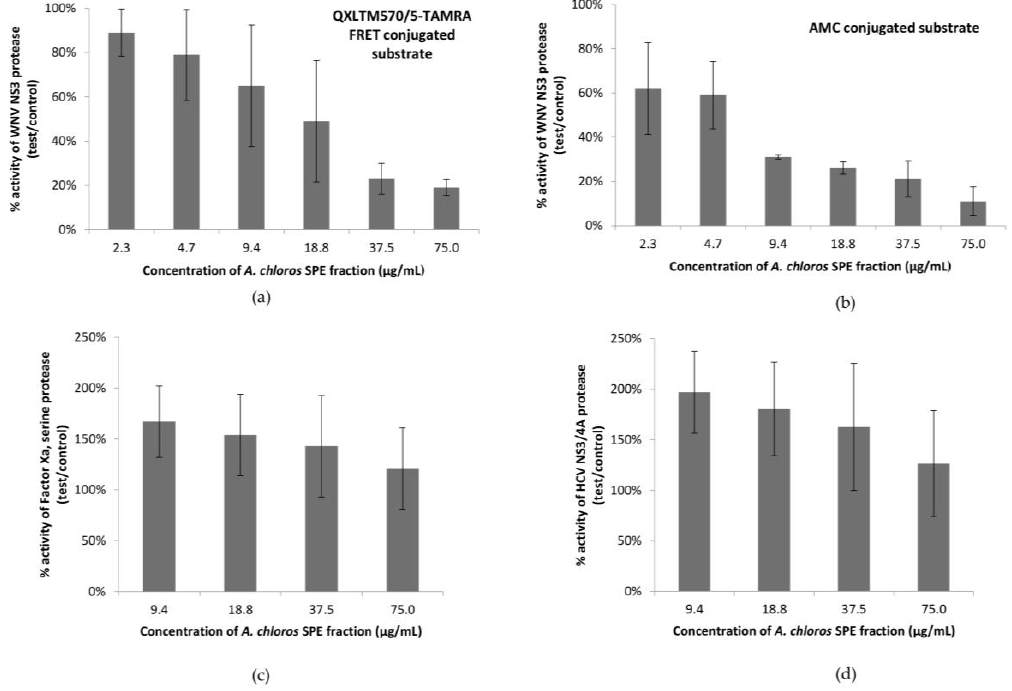
Figure 1. Percent activity of a series of serine proteases after treatment with SPE fraction 2 (50% IPA/H 2 O) from A. chloros in orthogonal biochemical assays. ( a ) Percent activity of the WNV NS3 protease in a biochemical assay with a QXLTM570/5-TAMRA FRET conjugated substrate; ( b ) Percent activity of the WNV NS3 protease in a biochemical assay with an AMC conjugated substrate; ( c ) Percent activity of the Thrombin-Factor Xa, serine protease complex in a biochemical assay with a QXL 520/5-FAM FRET conjugated substrate; ( d ) Percent activity of the HCV NS3/4A protease biochemical assay with a QXL 520/5-FAM FRET conjugated substrate . Error bars denote standard deviations.